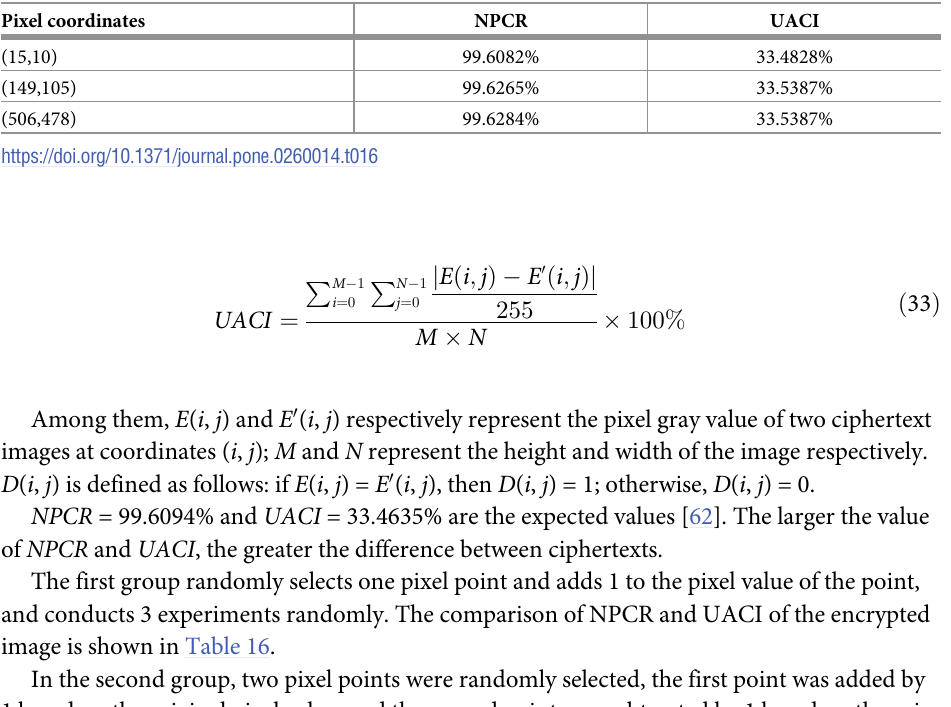
Table 16. Comparison table of NPCR and UACI with randomly changing 1 pixel.